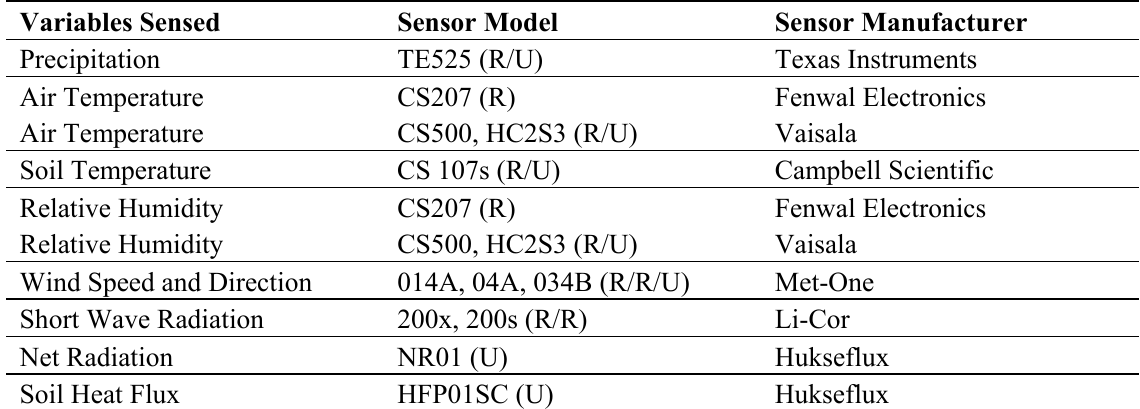
Table 2. Variables sensed and sensor model and manufacturer for urban gradient study sites in Columbia Missouri, USA. R and U indicate sensors used at Rural and/or Urban sites,